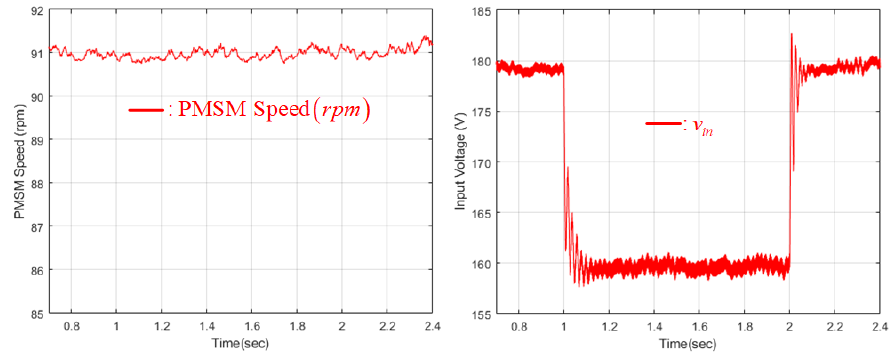
Figure 7. Permanent magnet synchronous machine (PMSM) speed and input voltage